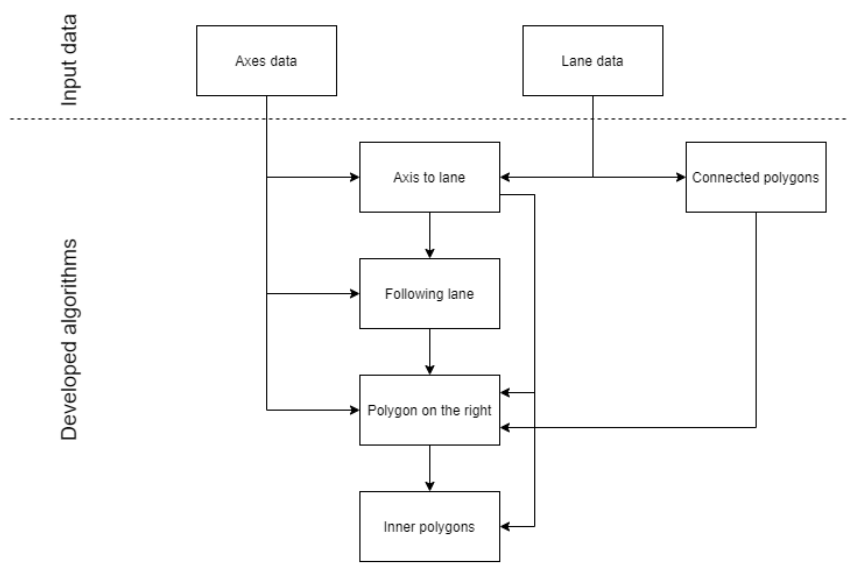
Figure 2. The developed